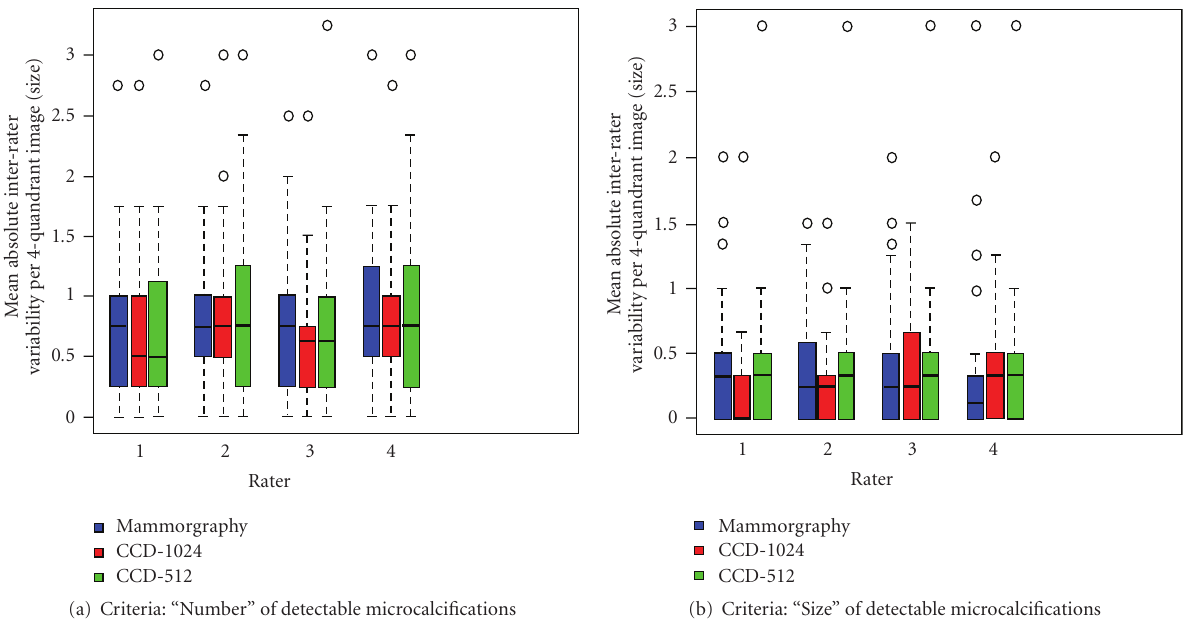
Figure 2: Mean absolute interrater variability of the 4 radiologists’ ratings from an experimentally preset reference values for each quadrant of the 48 universal laser printer films are presented here in box plots for the variables “number” and “size” separately for each rater. Statistical outliers are labeled with a dot ( • ). In the global comparison of all simulated microcalcifications, the diagnostic accuracy of direct digital flat-panel detector mammography system versus the small-field CCD stereotactic breast biopsy system utilizing was comparable, and independently of number, size, or shape of the silica